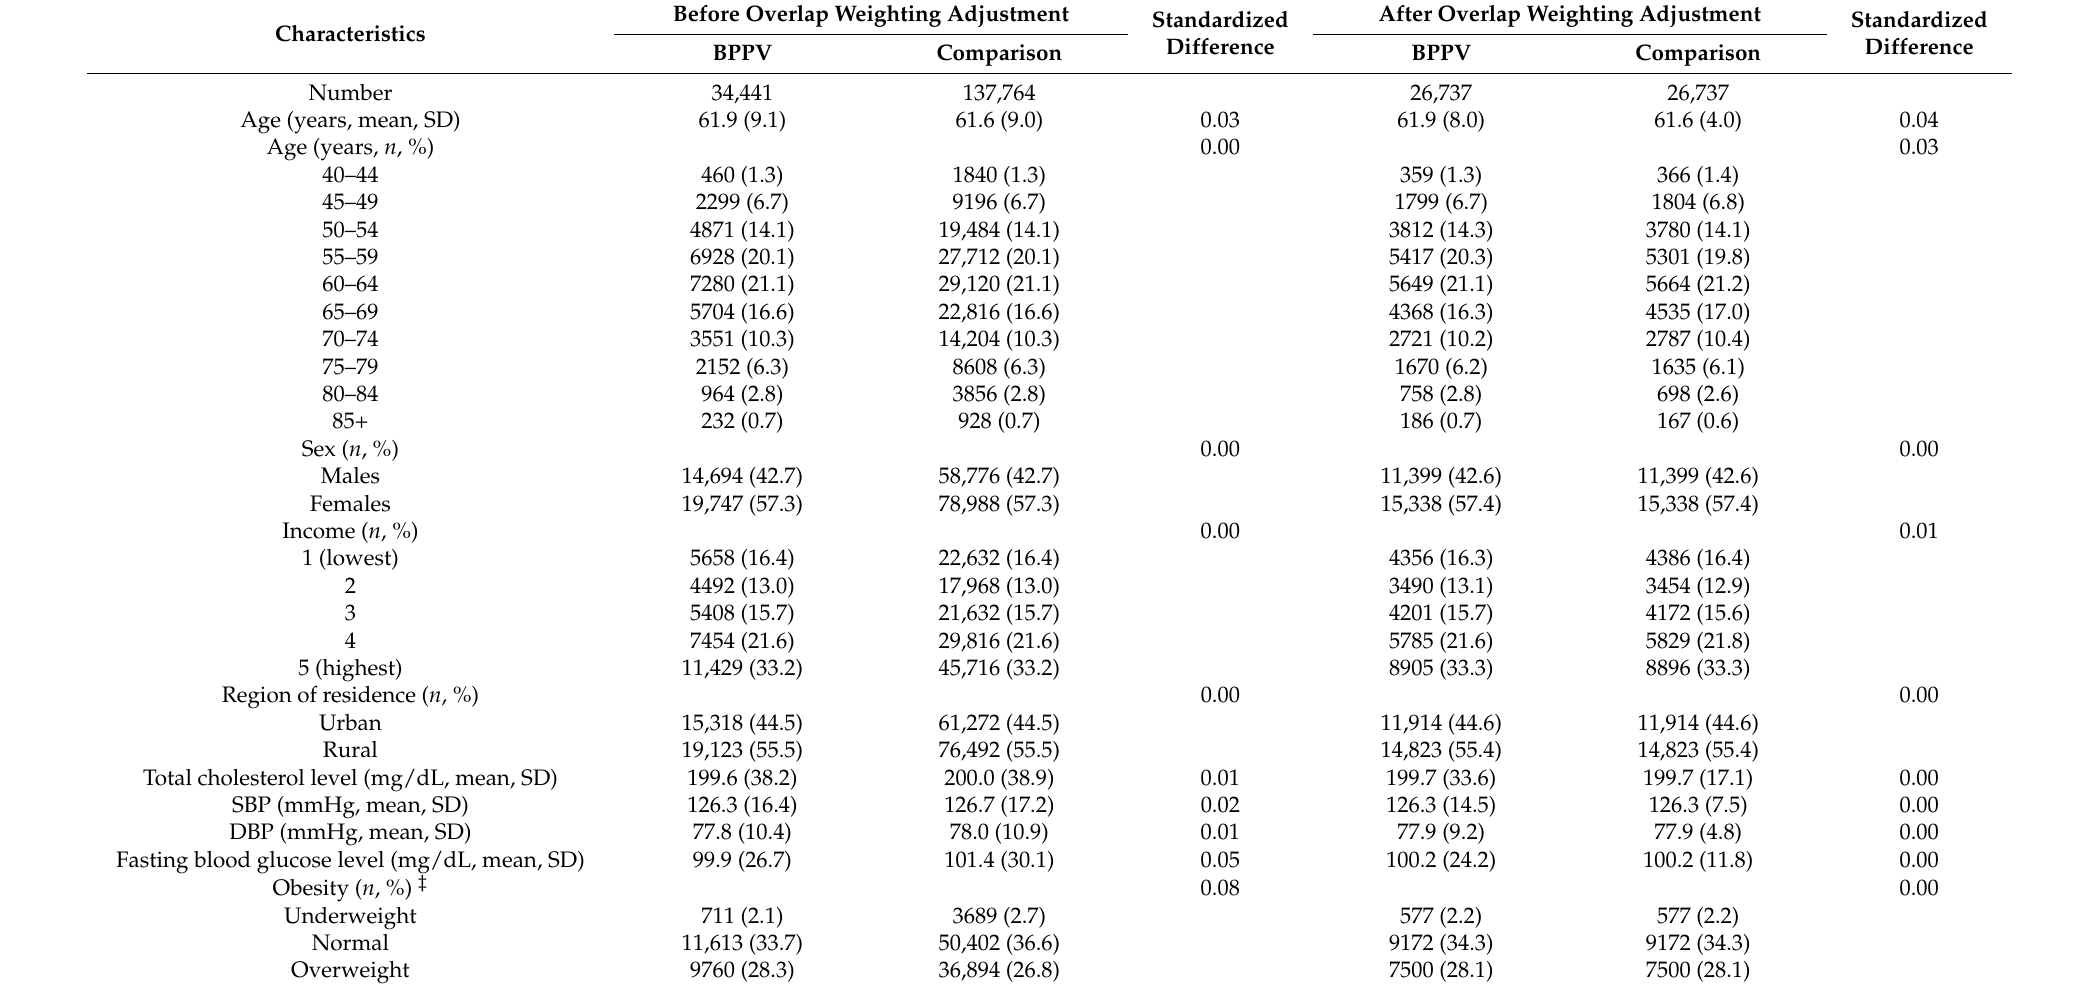
Table 1. General characteristics of participants before and after propensity score overlap weighting